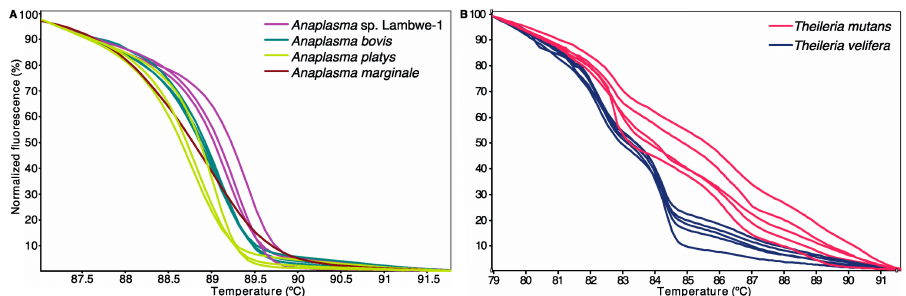
Figure 2. Normalized High-Resolution Melting (HRM) profiles of representative TBP detected ( A ) Anaplasma spp. and ( B ) Theileria spp. PCR amplicons.